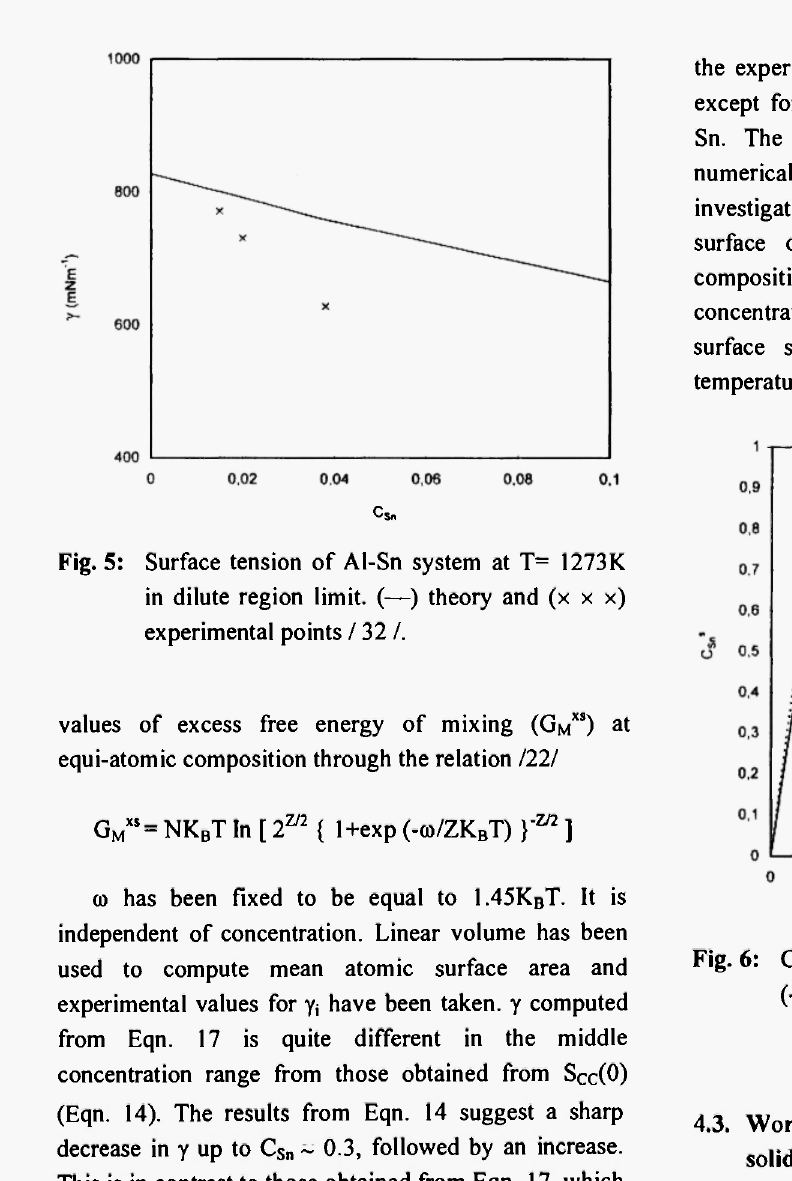
Fig. 6: C Sn s vs C s „ for Al-Sn liquid alloys at 973K ( ) and 1273K